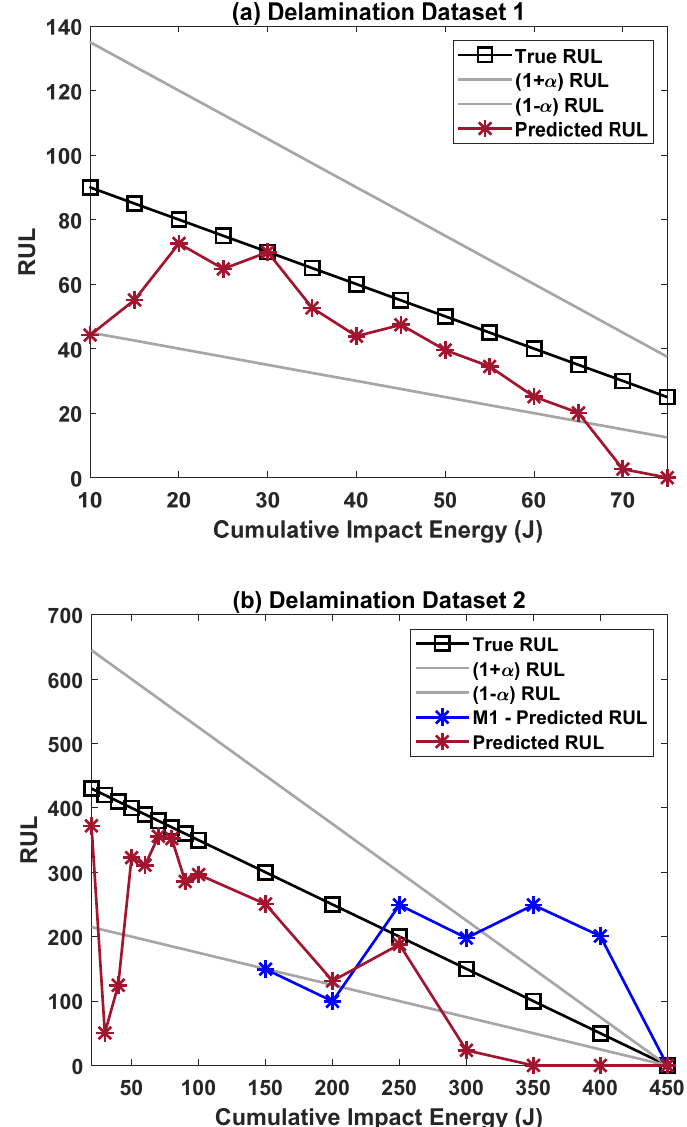
Figure 9. ( a ) RUL prediction results for GFRP sample S1 using the proposed online prognostic framework till 75J impact energy. ( b ) RUL prediction results for delamination dataset 2 using the proposed online prognostic framework till 450J impact energy. Note that M1 refers to the analysis results reported in Ref. [20], which we consider as the datum for comparison of the effectiveness of our framework. Here, the α value for the accuracy cone was chosen to be 0.5.